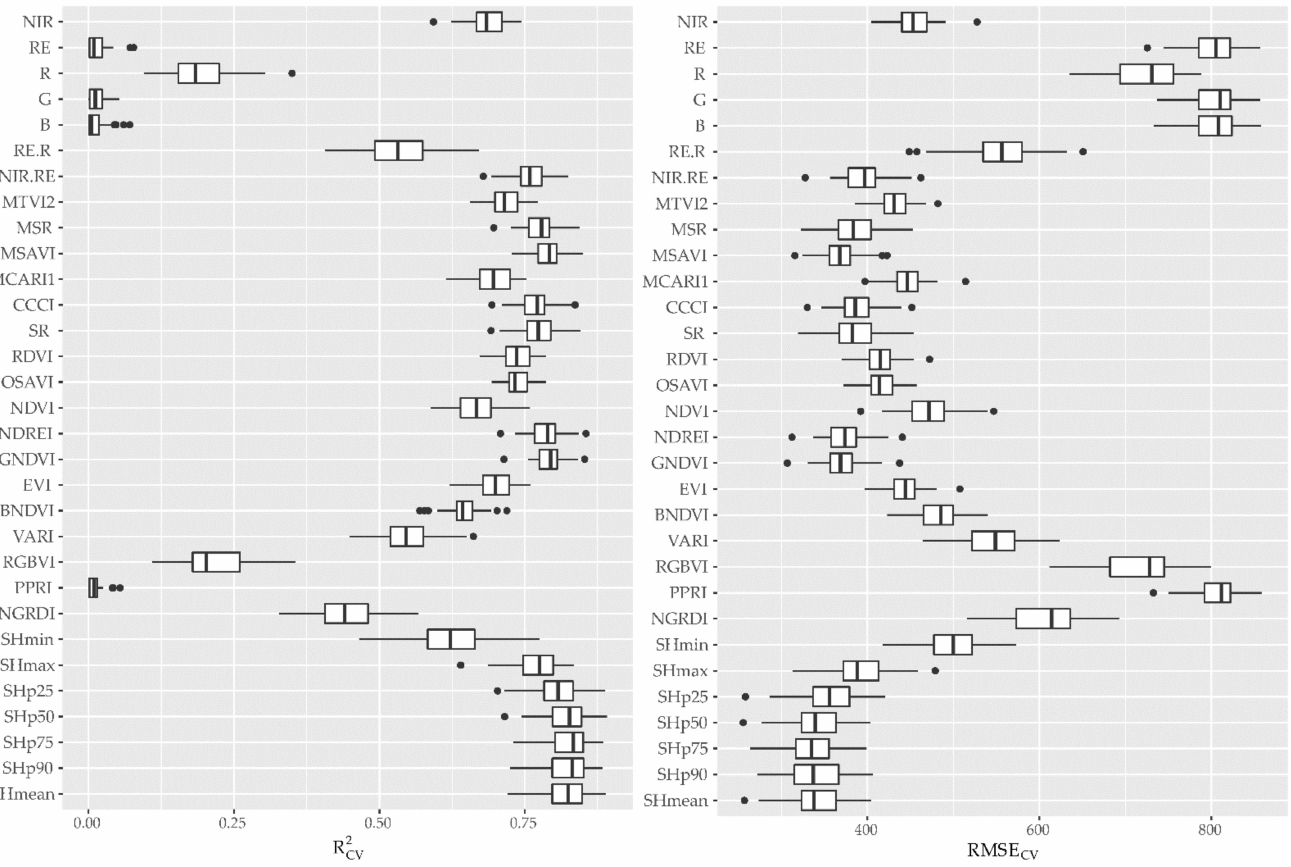
Figure 11. Box and whisker plot of R 2 CV and RMSE CV (kg ha − 1 ) of all resamples of linear models (simple linear regression) for herbage yield